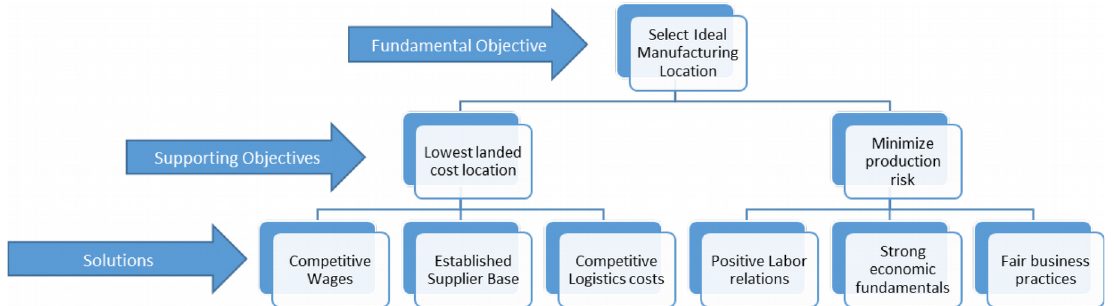
Figure 1. Fundamental objectives hierarchy